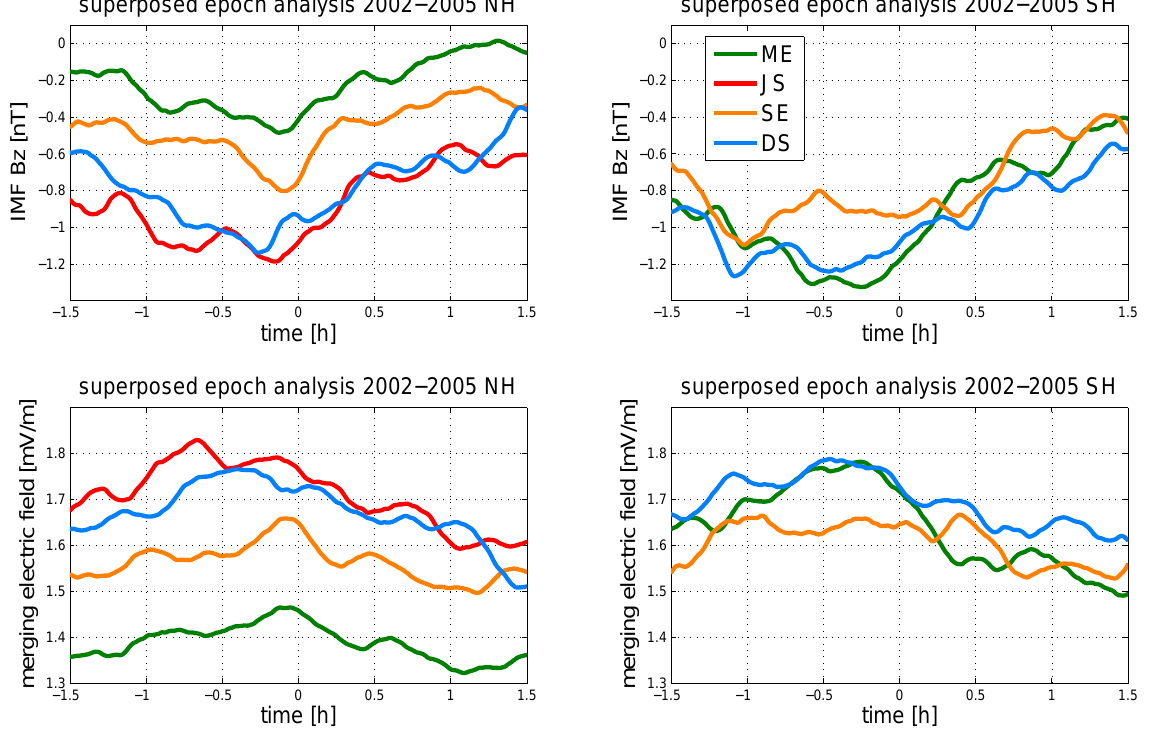
Fig. 6. Average variation of the IMF B z component (upper panels) and the IMF merging electric field, E merg , (lower panels) during the ± 1.5h around the density peak, as resulting from a superposed epoch analysis. Results from the different seasons are plotted separately. The green line indicates March equinox (ME) conditions, the red June solstice (JS), the orange September equinox (SE), and the blue line the December solstice (DS)